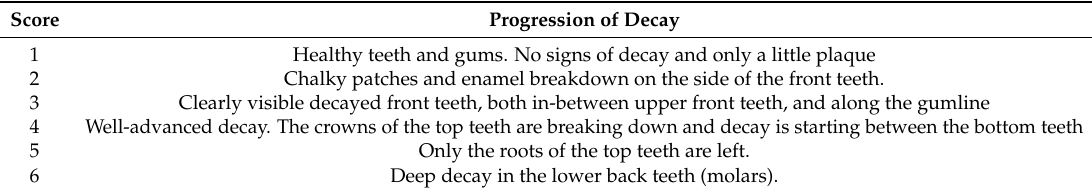
Table 2. Lift the lip 1 scoring for progression of